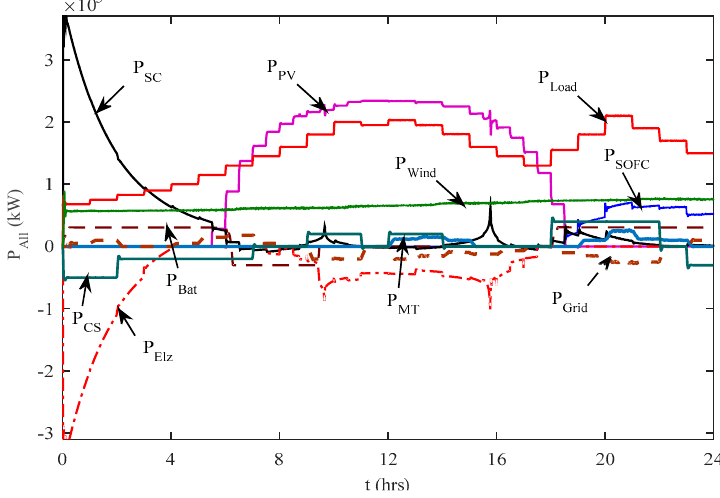
Figure 4. Load vs. generated powers of all sources. SC: super-capacitor; SOFC: solid oxide fuel cell; MT: micro-turbine; CS: charging station; Bat: battery; Elz: electrolyzer.